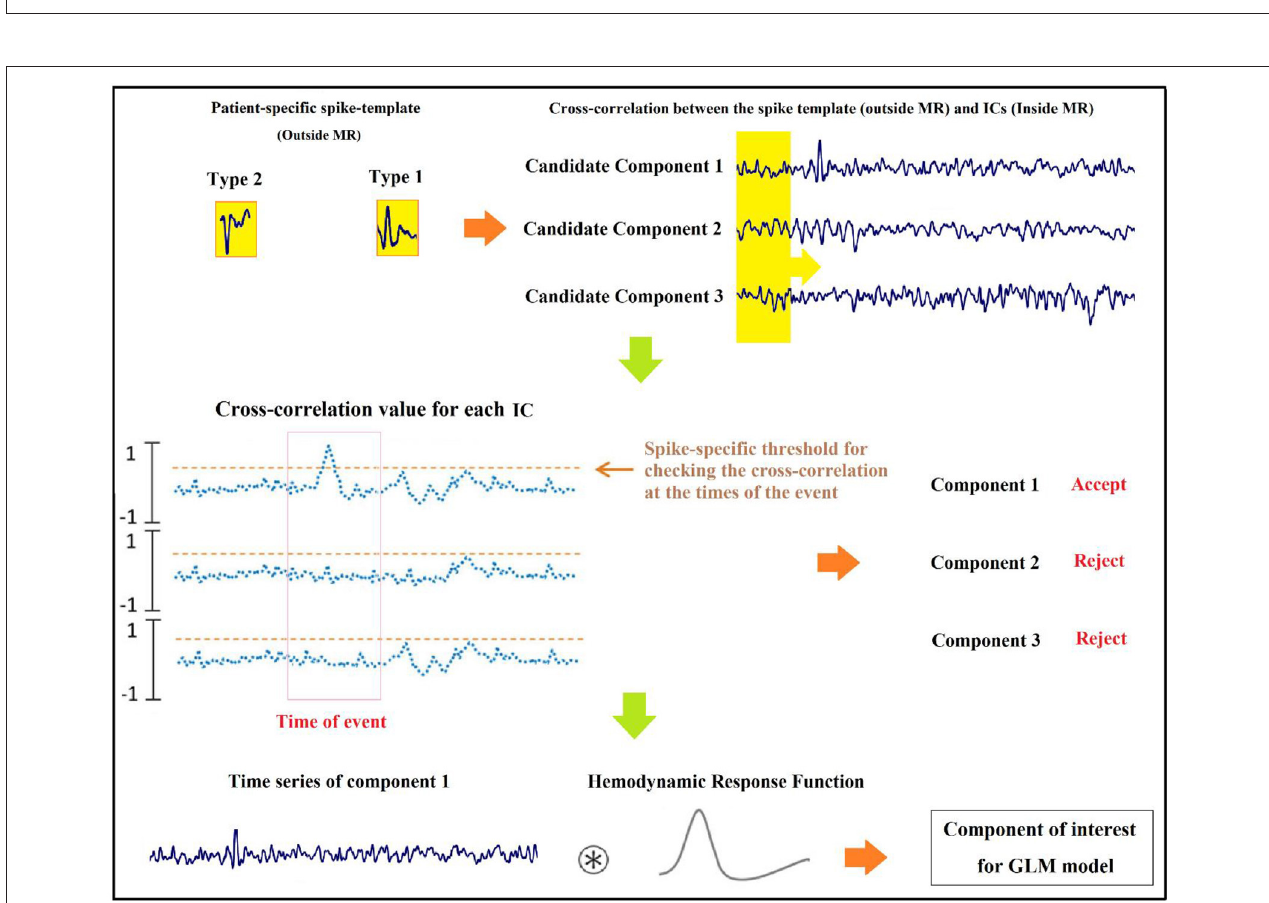
FIGURE 13 | Graphic illustration of the suggested method for identification of components